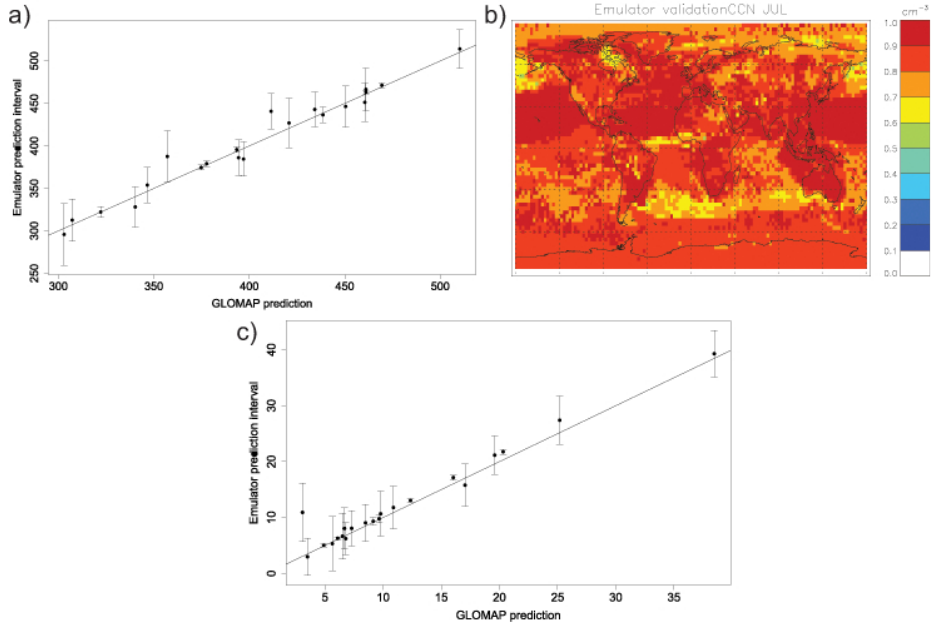
Fig. 1. Validation of the emulators. (a) shows the emulator prediction versus the GLOMAP prediction in an example grid box (b) a summary of Figure a for every grid box calculated by counting the percentage of GLOMAP predictions lying in the emulator prediction interval (c) an example grid box where the emulator does predict closely to the GLOMAP prediction but with so much confidence the GLOMAP prediction does not lie in the emulator prediction interval.